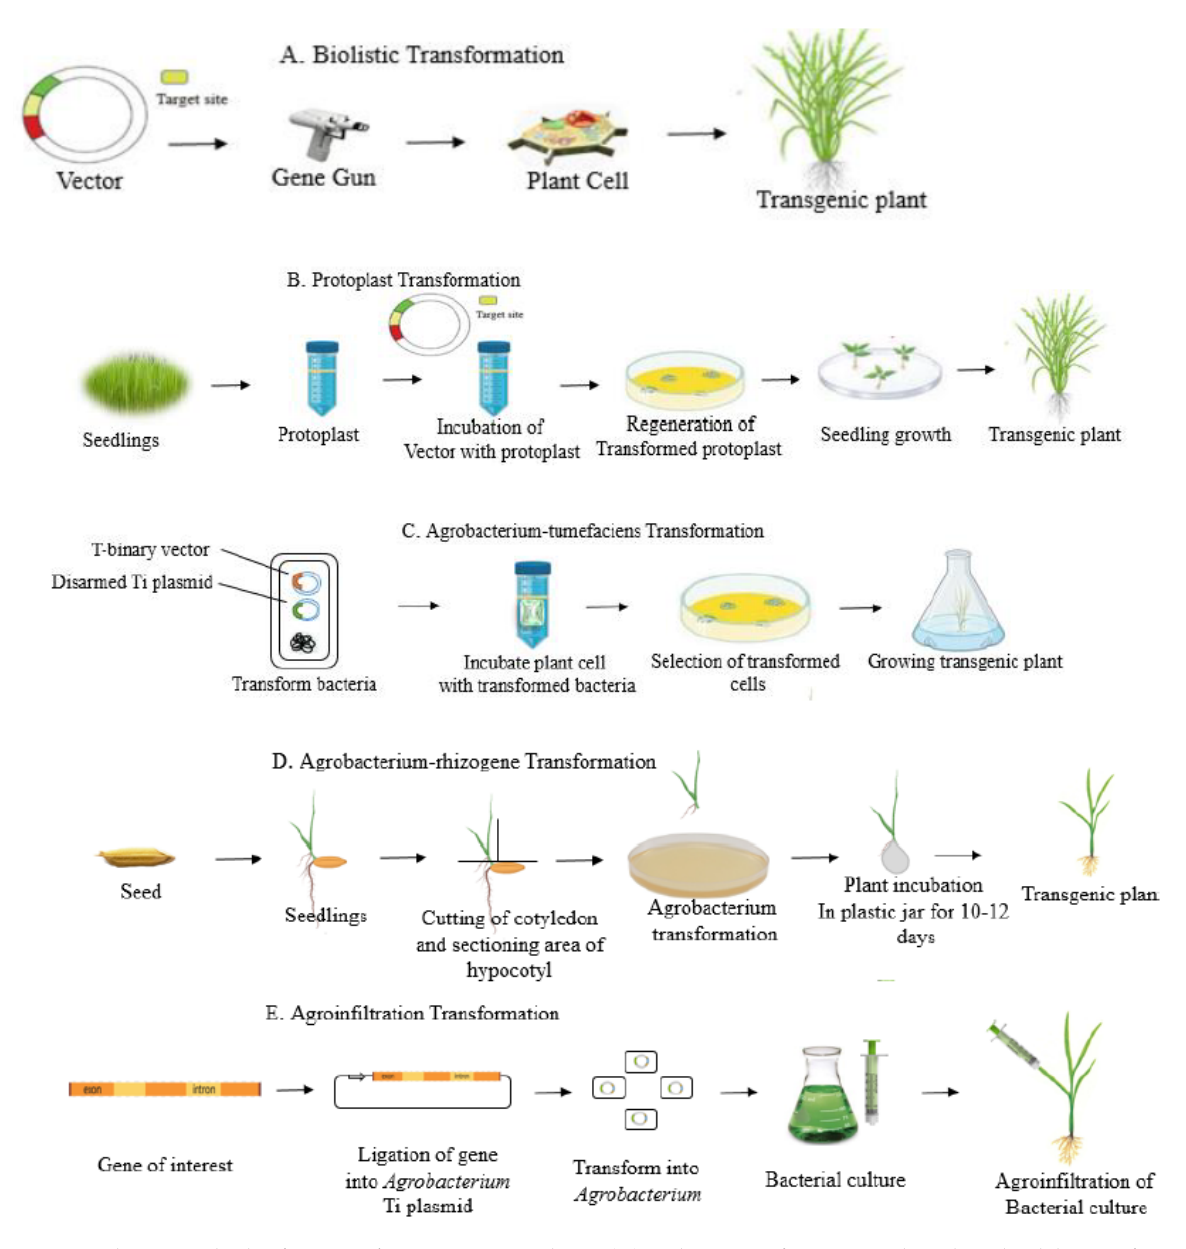
Figure 1. Delivery methods of CRISPR/Cas cargos into plants. ( A ) Biolistic transformation is based on the delivery of DNA into plant cells by high-velocity gold or tungsten particles with the help of a gene gun; ( B ) protoplast transformation involves the direct delivery of DNA into individual plant cells using polyethylene glycol or electroporation; ( C ) Agrobacterium-mediated transformations utilize the capability of the bacterial pathogen Agrobacterium tumefaciens to transfer foreign genes into a wide variety of host plants; ( D ) Agrobacterium rhizogene transformations transport single-stranded DNA (ssDNA; T-strands) and virulence proteins into plant cells through a type IV secretion system; ( E ) agroinfiltration transformations allow the suspension culture of agrobacterial cells to be infiltrated into the organs of an intact plant, providing a rapid and efficient way to transiently express foreign genes in planta.